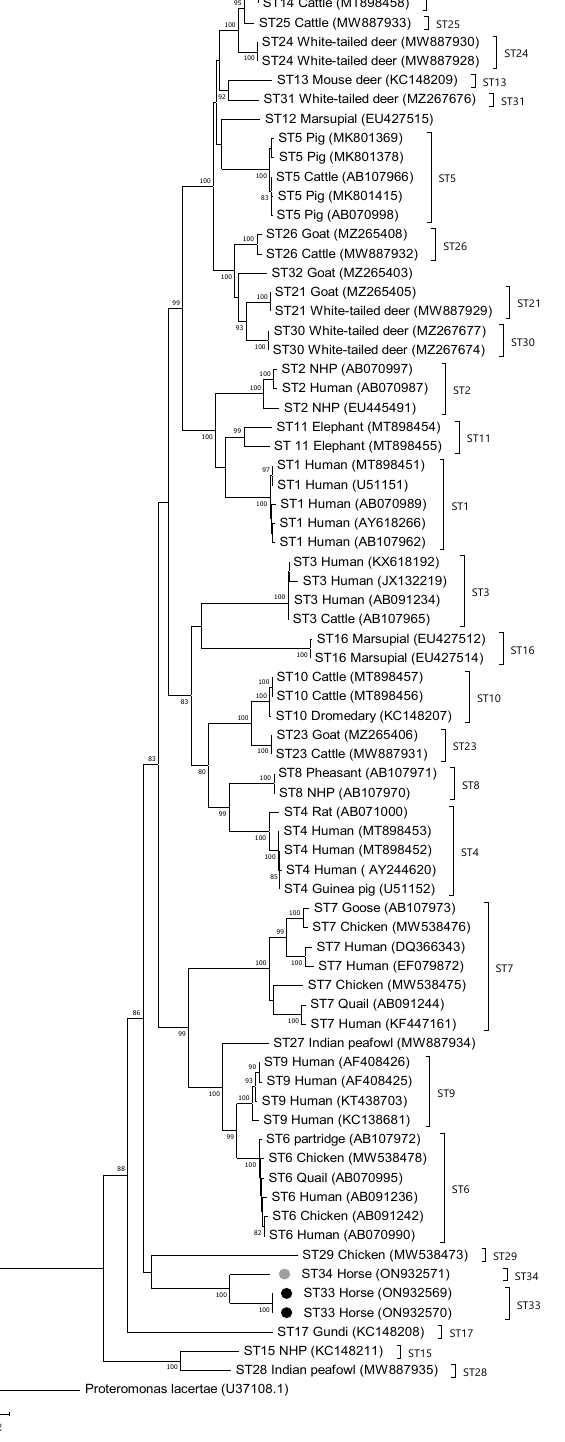
Figure 1. Phylogenetic relationships among Blastocystis full-length sequences generated in the present study (novel subtypes are new subtypes ST33 and ST34, which are denoted with black- and gray-filled circles, respectively) and representative reference sequences of all accepted subtypes. Proteromonas lacertae was used as outgroup taxon to root the tree. Analysis was conducted by a neighbor-joining method. Genetic distances were calculated using the Kimura two-parameter model. This analysis involved 74 nucleotide sequences, and there were a total of 1953 positions in the final dataset. Bootstrap values lower than 75% are not